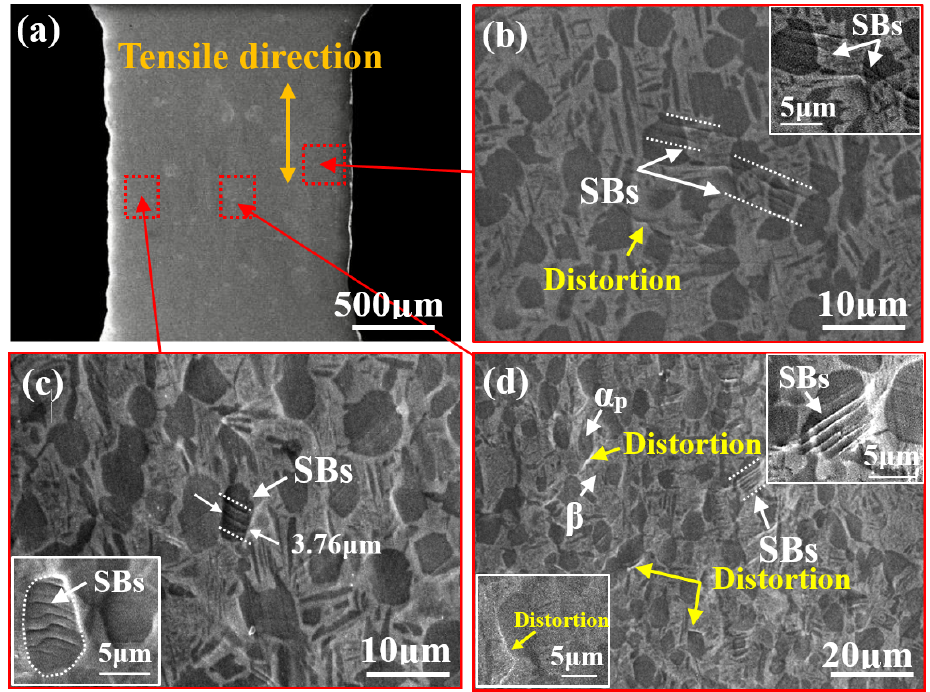
Figure 5. ( a ) In situ SEM images of the bimodal microstructure at position A; ( b ) magnified image showing SBs passing through the α p / β interface; ( c ) SBs formed in the region containing the α p phase; ( d ) distortion at the α p / β interface